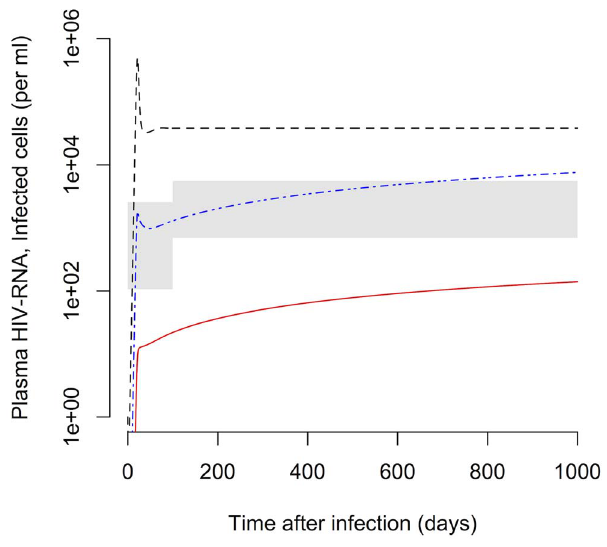
Figure 6. Development of the latently infected cell pool during acute and chronic of HIV-1 infection. The pool of latently infected cells ( L 1 + L 2 ) is shown as a red line, the number of HIV-1 DNA positive cells as a blue dash-dotted line and the plasma HIV-1 RNA as a black dashed line. The average parameter estimates from Table 1 were used for the model simulation. The gray areas represent two standard deviations around the mean of the number of HIV-1 DNA positive cells in patients that initiated cART during acute and chronic infection [33] (for details, see Text S1 ).